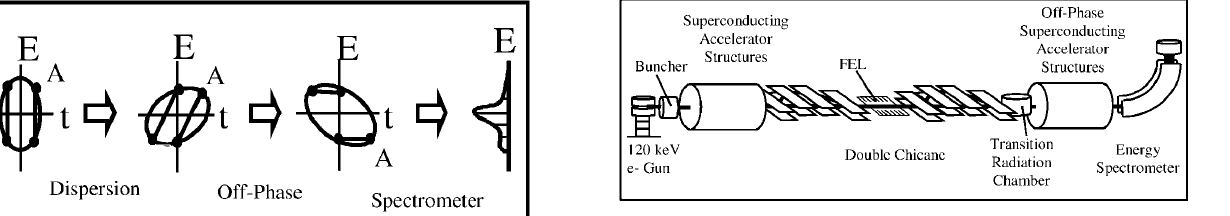
FIG. 2. Schematic diagram of part of the Stanford supercon- ducting accelerator bunch was alternately measured by off-phase acceleration and by